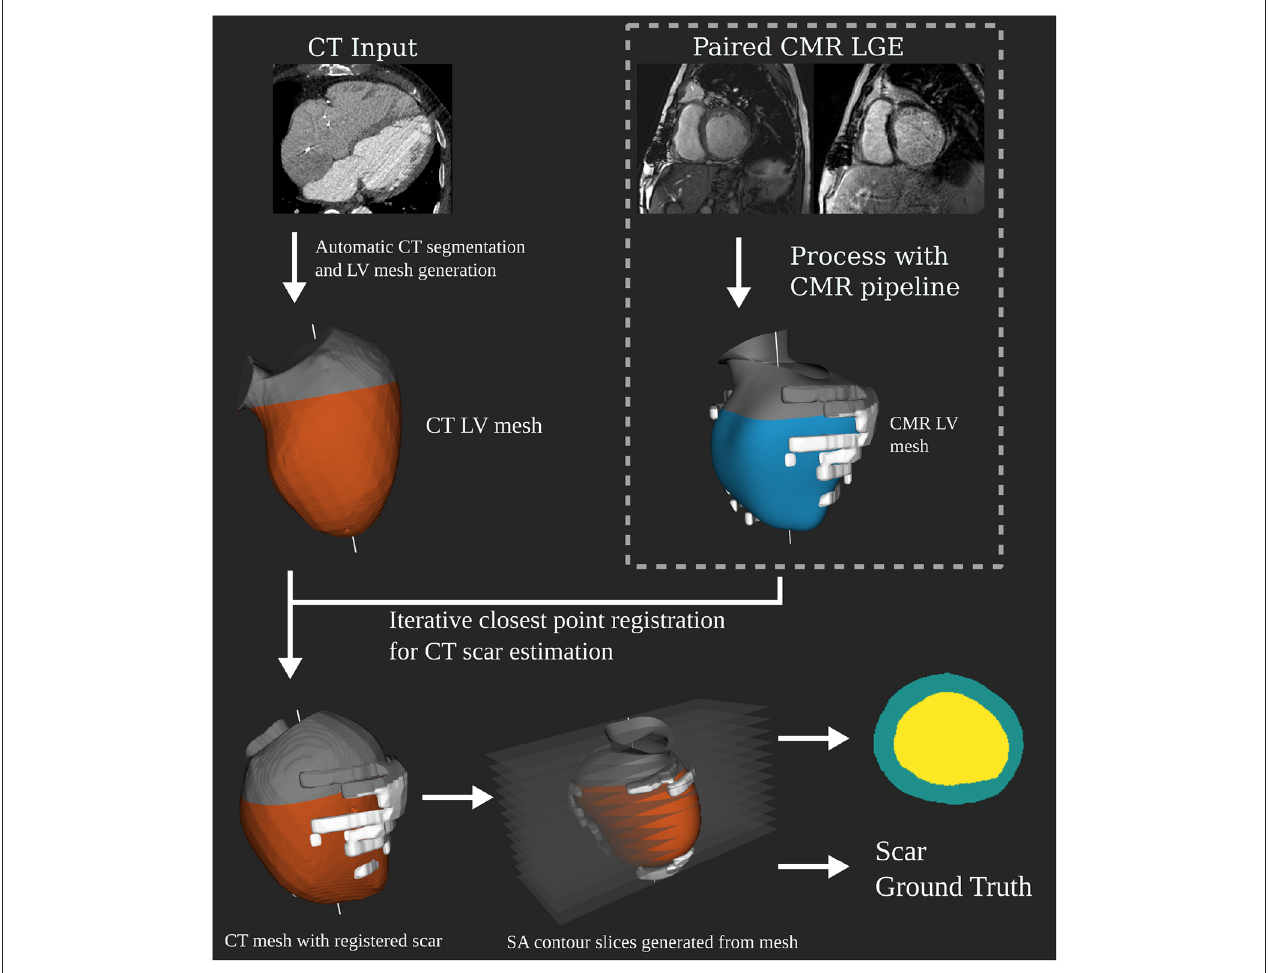
FIGURE 1 | Independent computed tomography angiography (CTA) test dataset generation pipeline. Showing how the CTA anatomical masks are created as input for the network at test time. Registration of the 3D scar segmentation from paired late gadolinium enhancement (LGE) magnetic resonance imaging (MRI) is performed to determine scar ground truth for the CTA anatomical mask